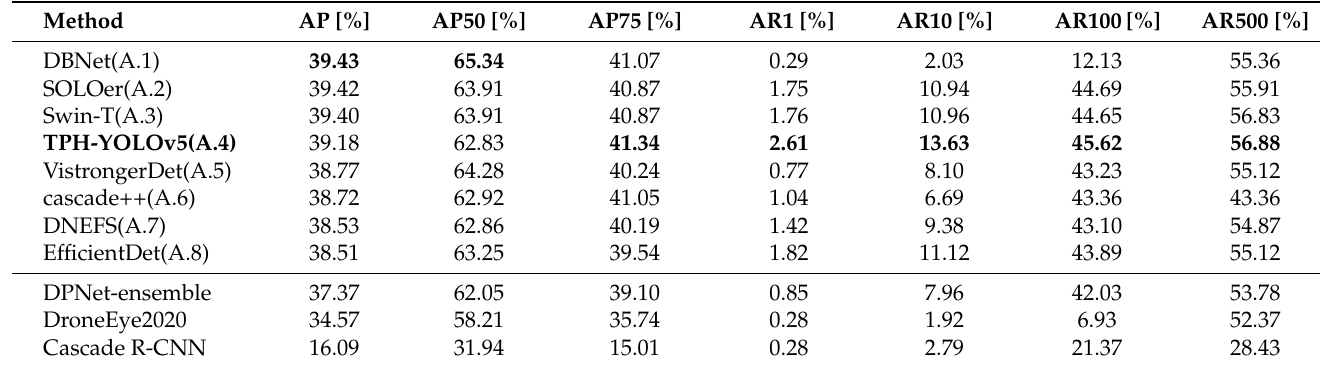
Table 1. Results of our TPH-YOLOv5 and other SOTA methods in the VisDrone Challenge 2021 test-challenge dataset, provided by the organizer of this challenge [59].